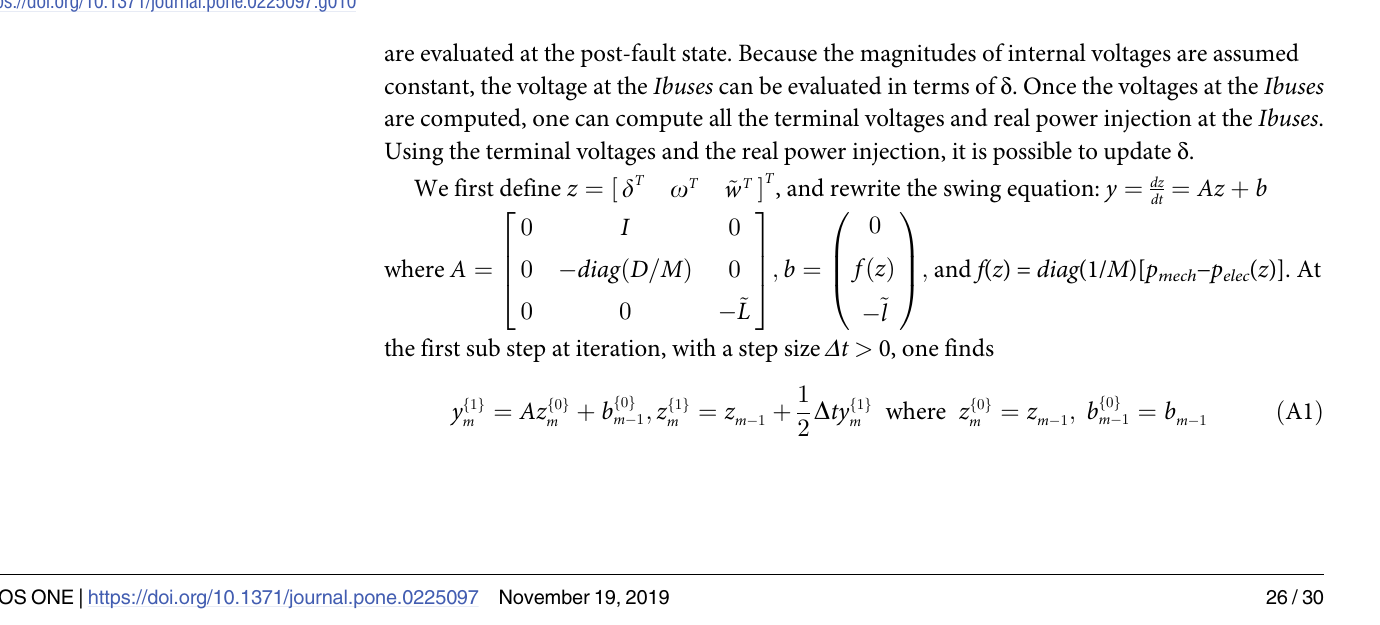
Fig 10. (A) Post-fault trajectories of the rotor angles and (B) trajectories of the voltage magnitudes, (C) O the fault is cleared at t = 1.1 seconds.